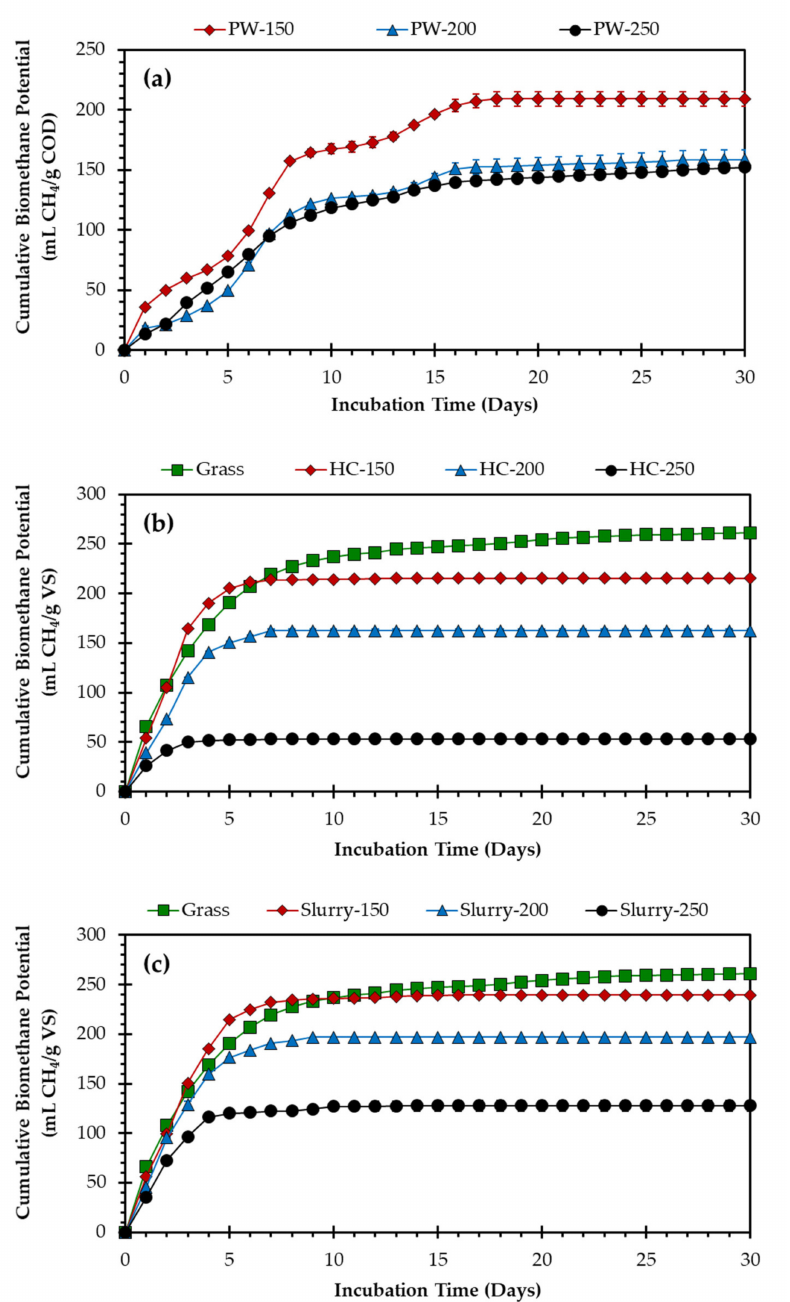
Figure 5. Experimental biomethane potential ( E BMP) of grass and HTC products: ( a ) process waters; ( b ) hydrochars; ( c ) slurries. Data are presented as average values. Error bars represent the maximum and minimum values ( n =